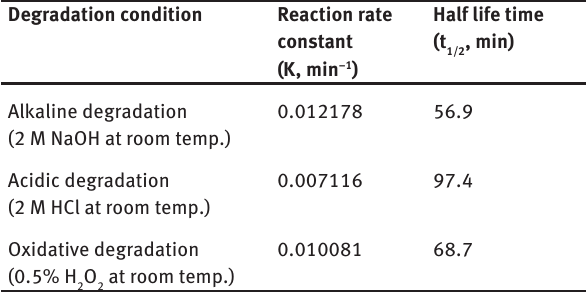
Half life time (t , min) 1/2